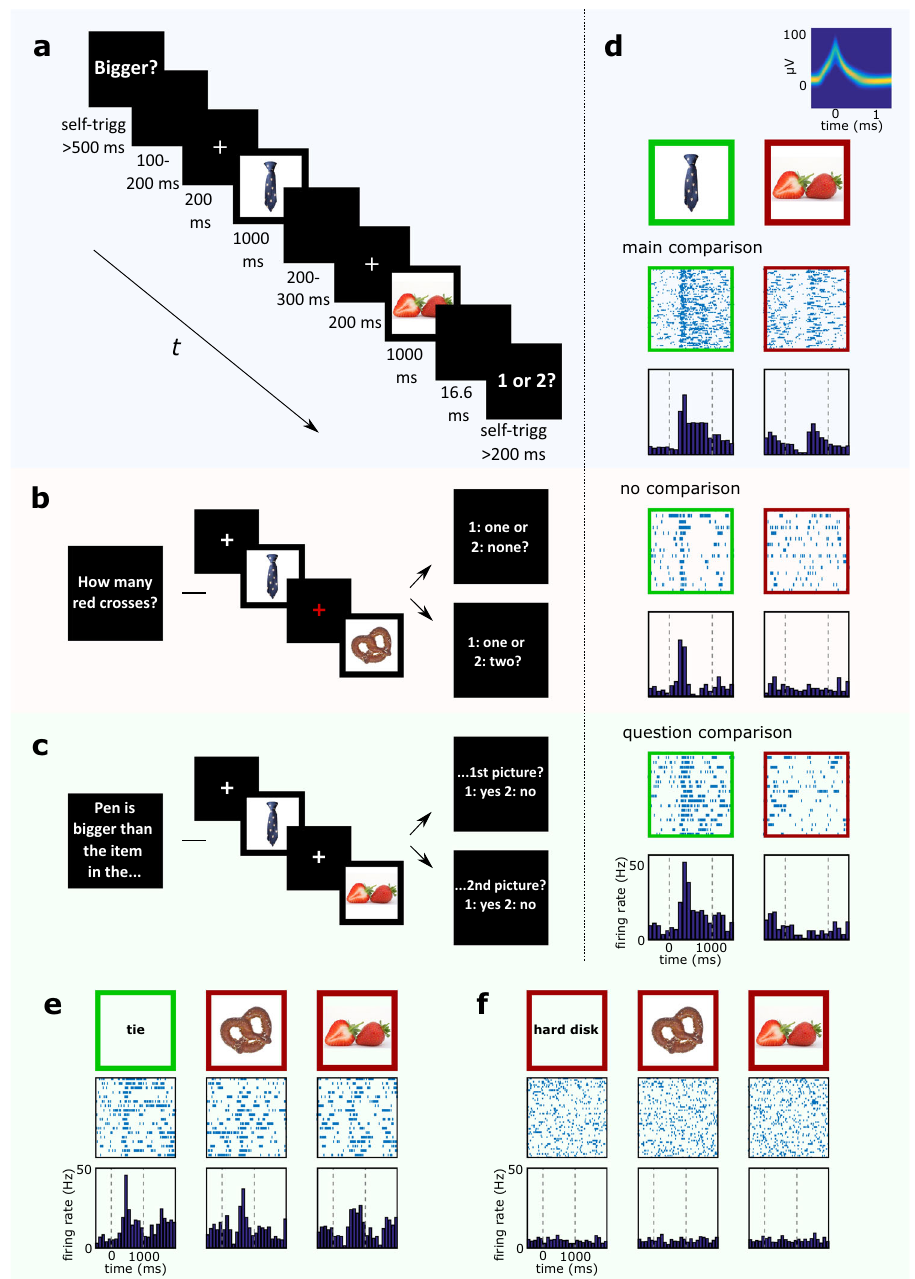
Fig. 1 Concept neurons respond after presentation of otherwise non-preferred stimuli whenever a comparison to the previously shown preferred stimulus is required. a Main-comparison condition (blue). Each trial contained one of fi ve questions ( “ Bigger? ” , “ Last seen in real life? ” , “ More expensive? ” or “ Older? ” , “ Like better? ” , ” Brighter? ” ), a sequence of two pictures (out of four), and an answer prompt displaying “ 1 or 2? ” . Subjects indicated the sequential position of the picture that best answered the question by pressing keys 1 or 2. Question and answer screens were self-triggered (self-trigg). Event durations are printed below. b No-comparison condition (red). Same structure as in a. Subjects had to count the number of red fi xation crosses. Neither, one, or both of them could be red. c Question-comparison condition (green). Similar to a, but here the question also referred to one of the stimuli by text. Two of the three remaining pictures followed. Subjects had to compare both pictures to the stimulus named in the question. d Raster plots, histograms and density plot of one concept neuron from all three experimental conditions ( a – c ) during fi rst and second picture presentations. Frame color indicates whether the stimulus was preferred (green) or non-preferred (red). This neuron responded not only to the preferred picture (tie) but became reactivated in response to any subsequent non-preferred picture (e.g., strawberry) whenever the task required a comparison to its preferred picture ( a ), but not otherwise ( b , c ). e Same neuron as in d during the question-comparison condition for trials in which the preferred concept (tie) was part of the question. A response to the question and to both subsequent non-preferred pictures was observed (pretzel and strawberry). f Same as in e for trials in which neither the question, nor the subsequent pictures contained the preferred concept. The neuron did not respond at all. Pictures of objects ( a – f ) were obtained from https://commons.wikimedia.org under the Creative Commons CC0 1.0 Universal Public Domain